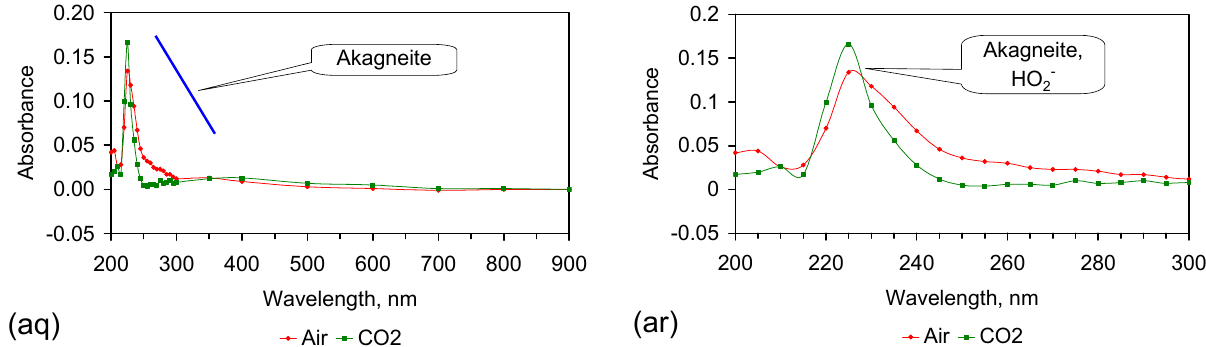
Figure C37. Nano-particle UV-Visible spectrograms: ( a ) Trial E145, 200–900